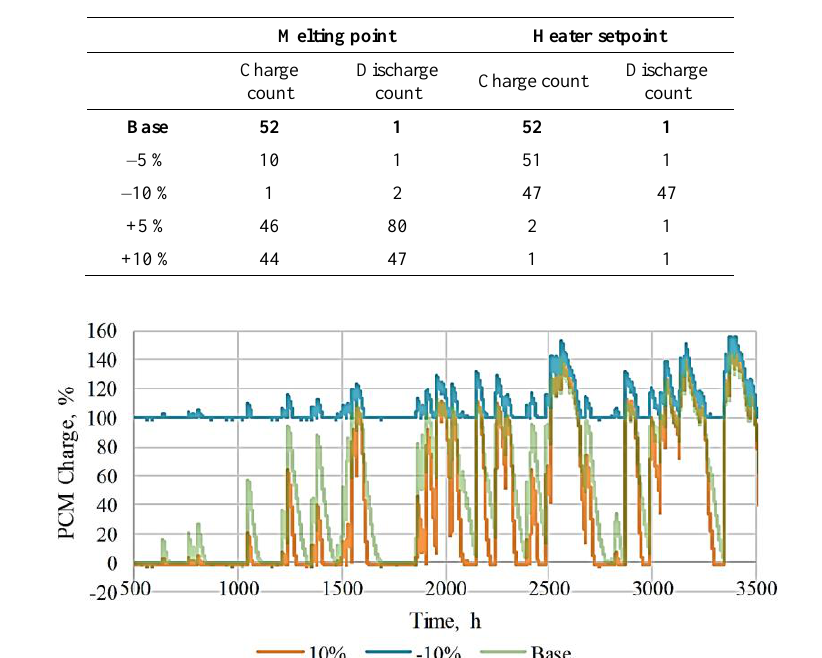
Fig. 7. Minute data for part of the year of PCM charge data for the base case and cases with increased and decreased by 10 % melting temperature of